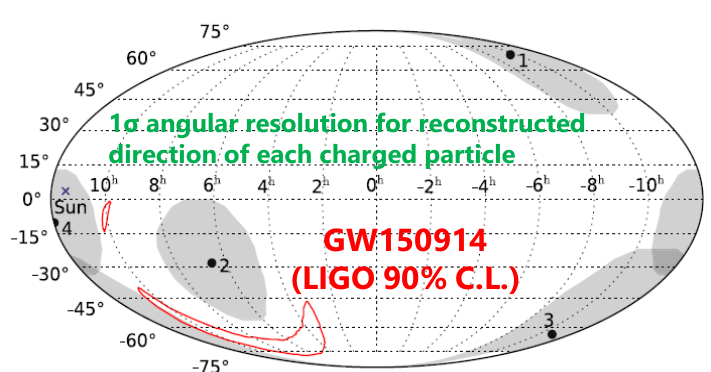
Figure 2. Reconstructed directions of the charged particle in the remaining four events associated with GW150914. The red region is the 90% C.L. contour for the location of GW150914 by LIGO [1]. The black points are the remaining events together with their angular resolution (gray region). The cross is the location of the Sun at the detection time. The original figure was adopted from